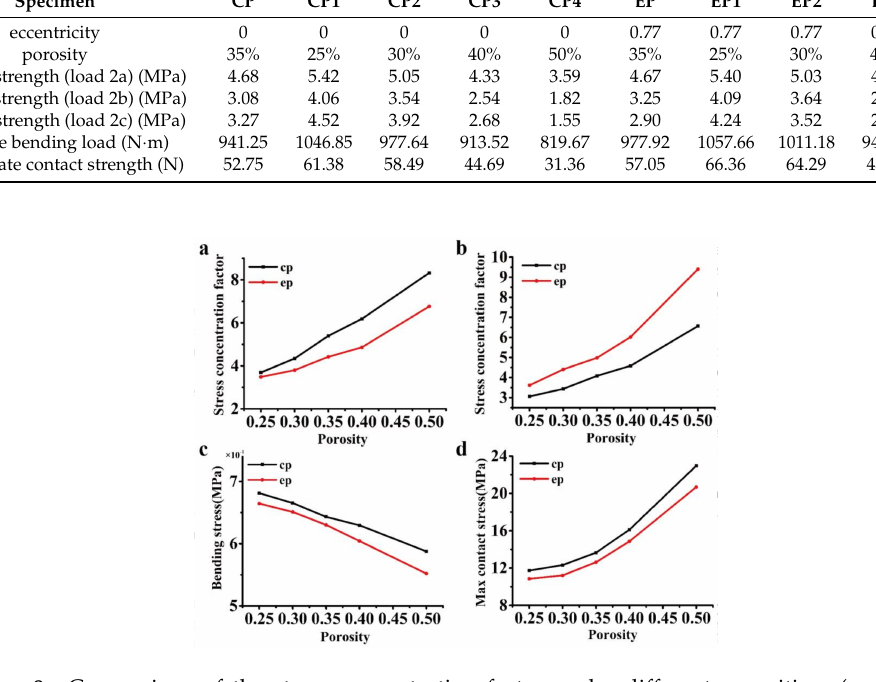
Figure 8. Comparison of the stress concentration factor under different porosities: ( a – d ) stress concentration factor according to the loading cases in Figure 2b–e.